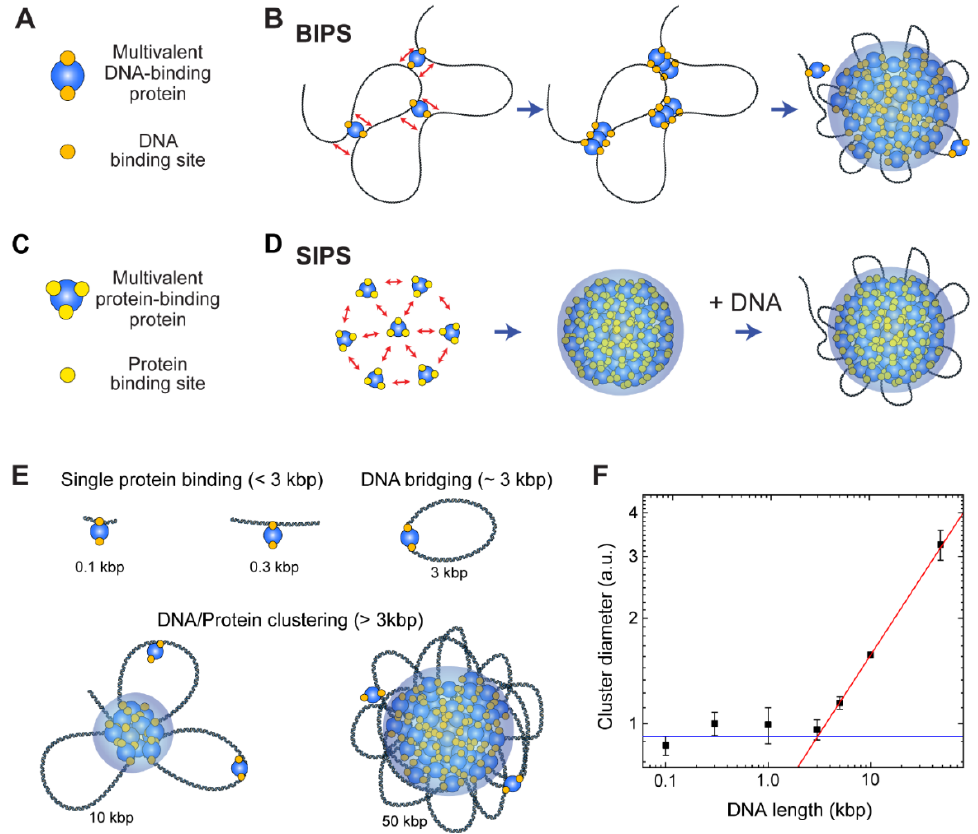
Figure 5. BIPS versus SIPS. ( A ) Cartoon of a multivalent DNA-binding protein that has at least two DNA-binding sites. DNA-binding sites of the protein are depicted as orange circles, and the protein is denoted as a blue circle. ( B ) Schematic of the BIPS model. Two DNA-binding sites per protein are sufficient for condensation, and a long DNA molecule is irreplaceable in this mechanism. ( C ) Cartoon of a multivalent protein-binding protein that induces typical phase separation. Yellow circles on the protein (blue circle) depict protein binding sites. ( D ) Typical phase separation mechanism (SIPS), which uses multivalent protein-protein interactions. At least three binding sites are necessary for phase separation, and DNA plays an auxiliary role in this process. ( E , F ) Dependence of the protein-DNA cluster size on the length of DNA shown in the previous study of cohesin-mediated BIPS [20]. ( E ) Cartoons of possible protein-DNA complex topologies for a range of DNA lengths and ( F ) a plot showing cluster size versus DNA length [20]. With <3 kbp of DNA, a single protein binds to DNA with no cooperativity (blue line). With ~3 kbp DNA, multivalent DNA-binding proteins can bridge a DNA to form a loop. For longer DNA (>3 kbp), a larger cluster can be formed, and the cluster size scales as a power law with the DNA length (red